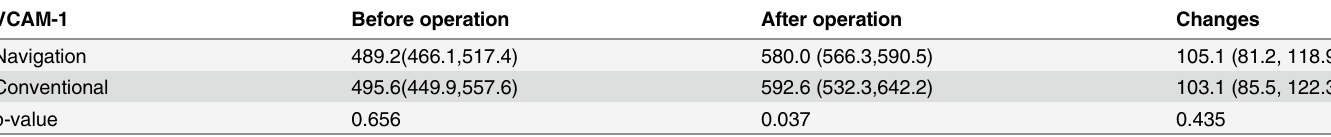
Table 3. Serum concentrations of VCAM-1 (unit:ng/mL) in patients before and after navigation and conventional TKAs, and the changes from pre- operative baseline after surgery (post-OP — pre-OP). VCAM-1